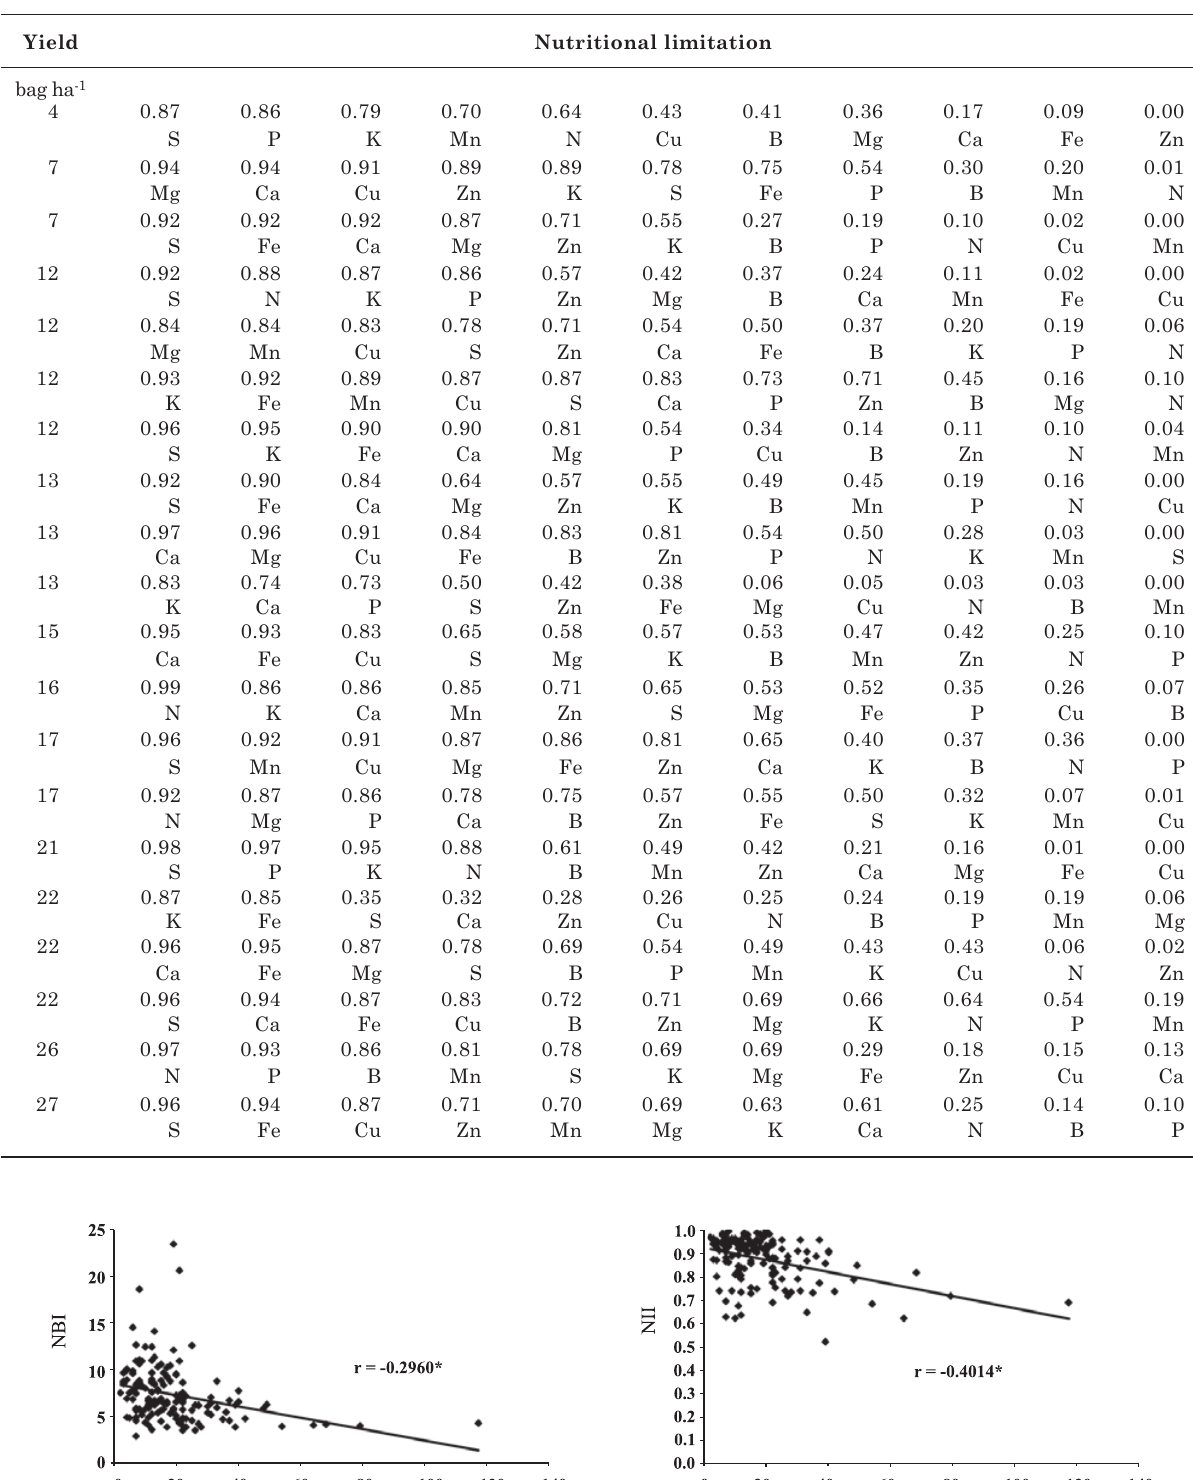
table 5. Classification of the nutritional limitation using the FRL for coffee crops that did not coincide with the dris yield